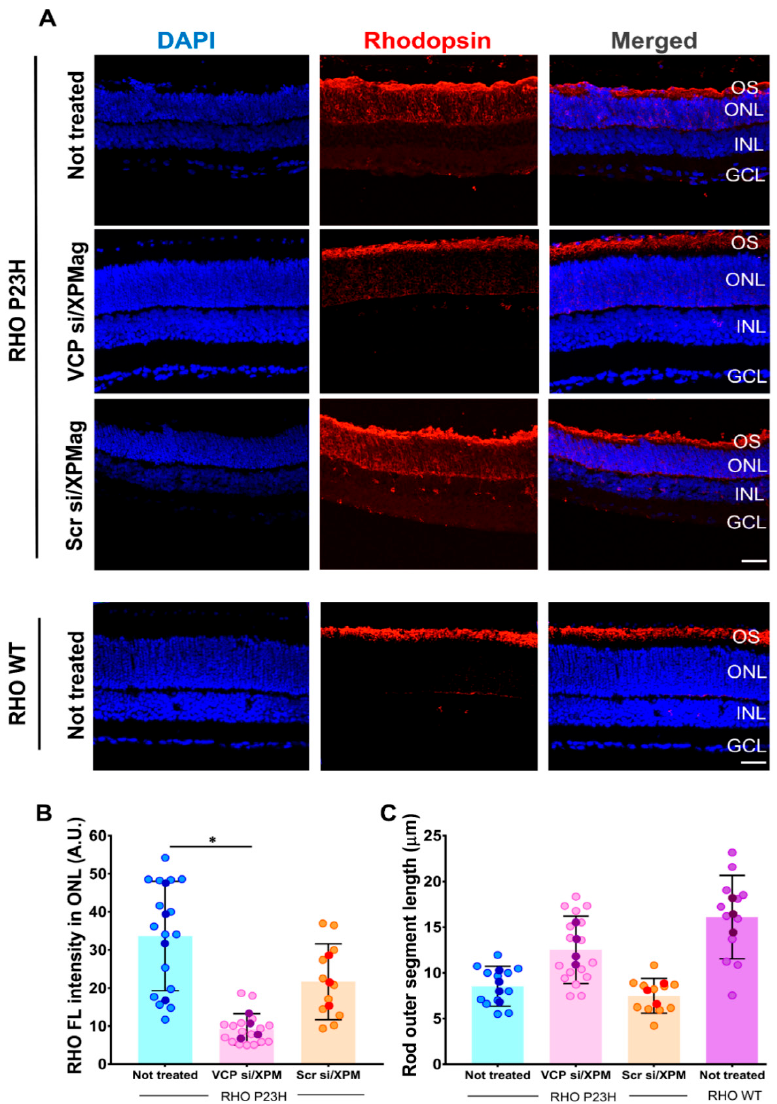
Figure 7. VCP downregulation via Reverse Magnetofection corrects the subcellular localization of rhodopsin (RHO) and increases the length of the OS in RHO P23H rat retina explants. Retinae of RHO P23H transgenic rats and WT rats were explanted on postnatal day 12, cultured in vitro for three days. RHO P23H retinae were treated with 50 nM VCP si/XPMag and 50 nM Scr si/XPMag by Reverse Magnetofection. The untreated age-matched WT retina group was used as a positive control. ( A ) The fluorescent marker in cryosections indicates the localization of RHO (red staining). ( B ) Quantification of RHO mean immunofluorescence intensity in the ONL. A central region of each image was selected, and the mean maximum intensity was assessed using the Zen 2.3 software. VCP silencing reduced the RHO fluorescence intensity in the ONL. ( C ) The mean length of the OS was higher in VCP silenced retinae cultures compared to untreated and scrambled siRNA controls ( C ). Scale bar 50 µ m. The values were quantified by scoring several images (circles) from four retinae ( n = 4) per treatment for not-treated RHO P23H, four retinae ( n = 5) per treatment for VCP si/XPMag in RHO P23H, three retinae ( n = 3) per treatment for Scr si/XPMag in RHO P23H, and three retinae ( n = 3) per treatment for not-treated WT. The data are presented as mean ± SD, and one-way ANOVA analysis was performed at * p < 0.05. The error bars correspond to the standard deviation. Abbreviations: VCP si: VCP siRNA, Scr si: scrambled siRNA, OS: outer segment, ONL: outer nuclear layer, INL: inner nuclear layer, and GCL: ganglion cell layer, RHO: